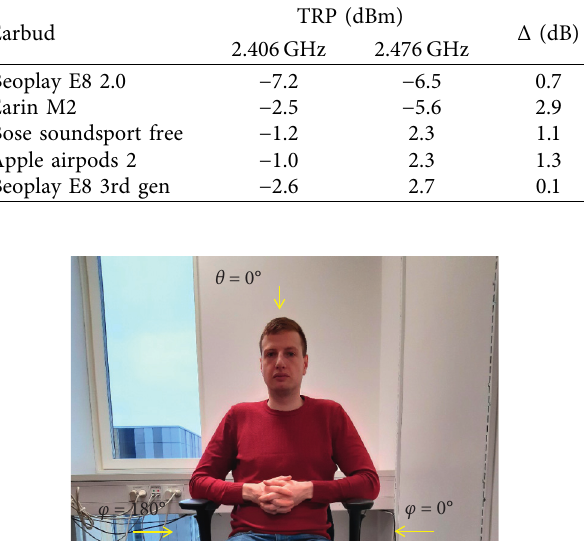
Table 1: Measured TRP of the right-side earbuds in free space.